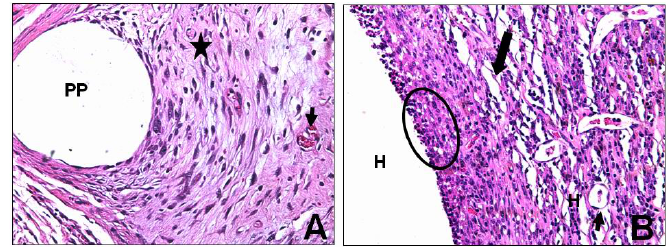
FIGURE 4 - Photomicrography of tissular response to polypropylene mesh and polypropylene-hydrogel implants, 30 days after implantation (HE, 200x); ( A ) Group PP sample evidentiating dense connective tissue around the polypropylene monofilament biomaterial (arrow) and angiogenesis (short arrow); ( B ) Sample from group PH with presence of loose connective tissue (long arrow), accentuated mononuclear presence (circle) and angiogenesis. Whereas: PP – site taken by polypropylene monofilament; H – site taken by hydrogel